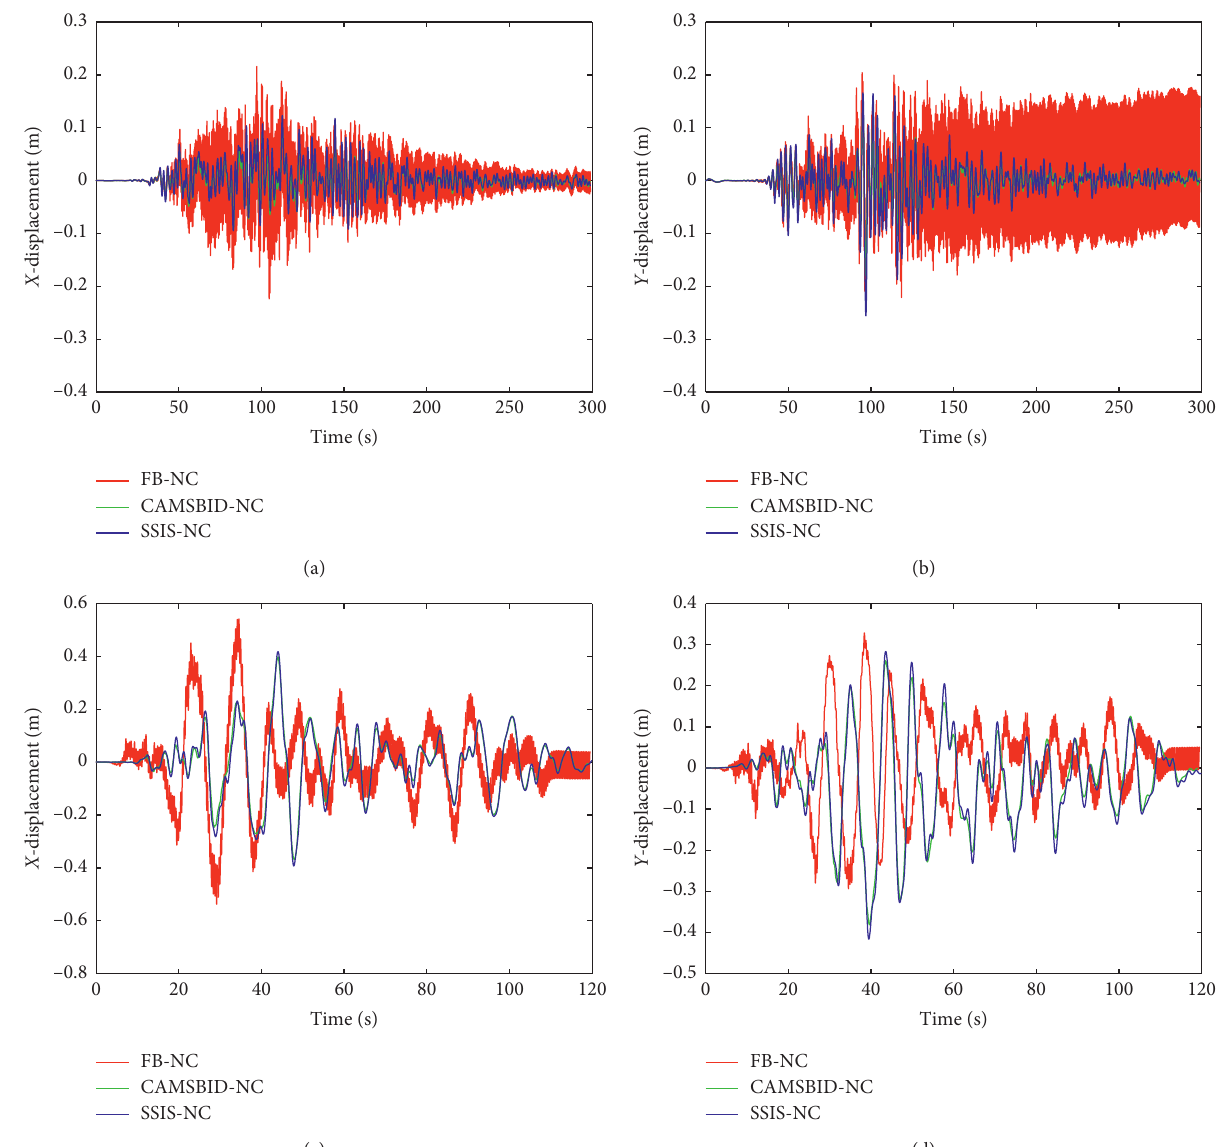
Figure 10: Top-level displacement responses of SSIS-NC (blue) in comparison with CAMSBID-NC (green) and FB-NC (red) under the effect of 2011 Tohoku (a, b) and 2010 El Mayor (c, d)